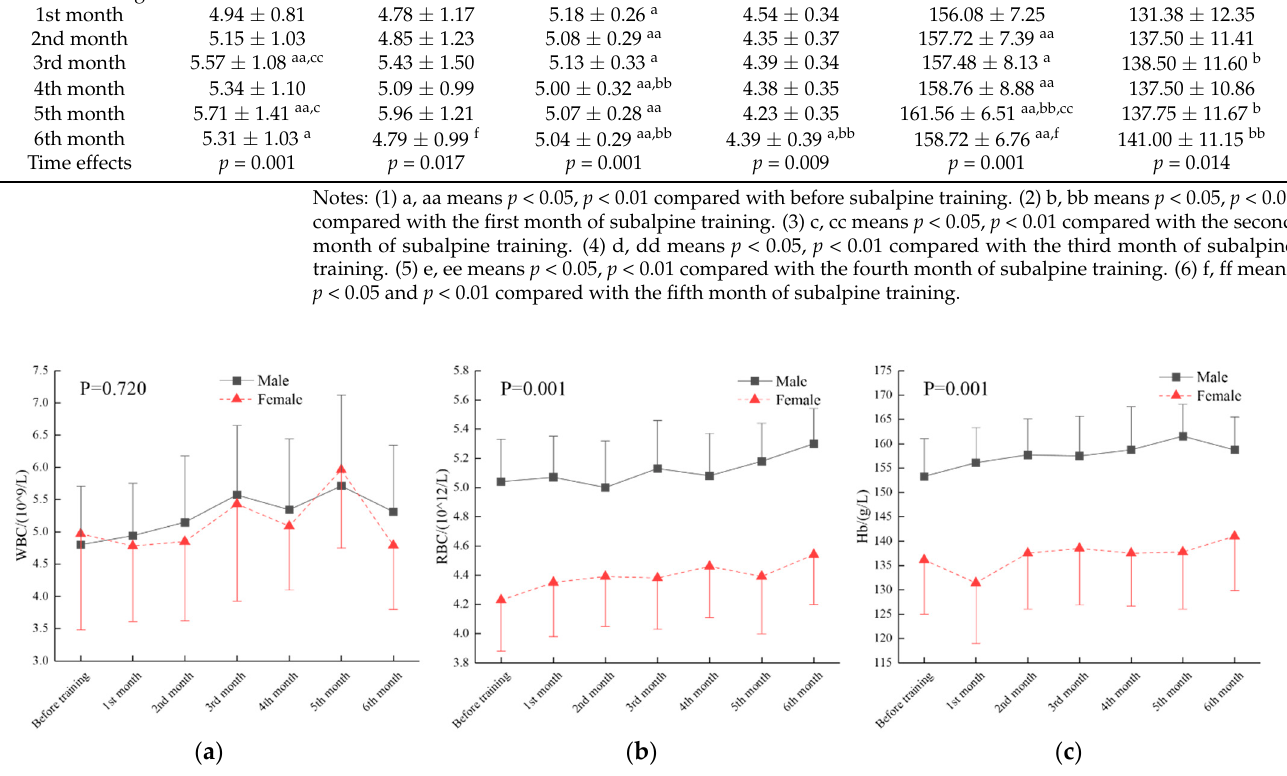
( c ) Figure 3. The results of changes in C, CK, and BU in the blood of athletes: ( a ) Changes of C in blood at different times; ( b ) Changes of BU in blood at different times; ( c ) Changes of CK in blood at different times. Data are mean ± SD.